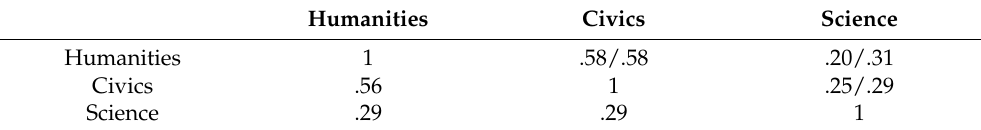
Table 6. Correlation Matrix of the Knowledge Domains (All Samples).